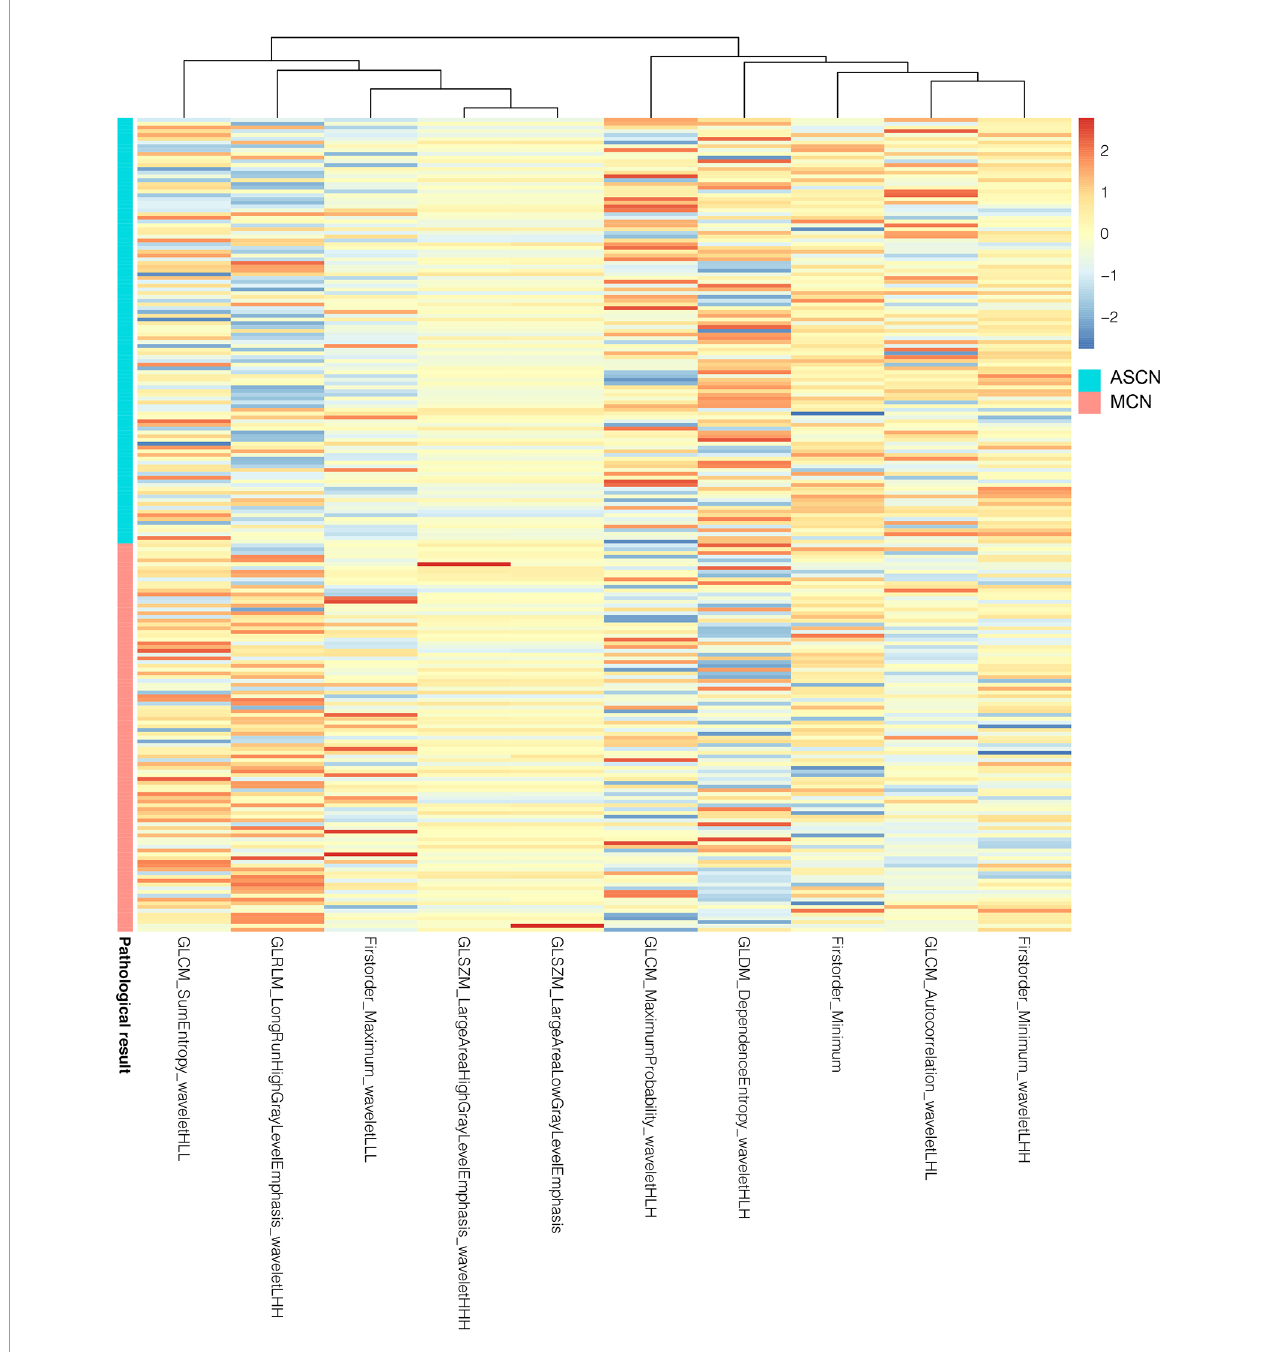
FIGURE 4 | Heatmap of 10 optimal radiomics features of 216 enrolled patients. The radiomics features were normalized according to